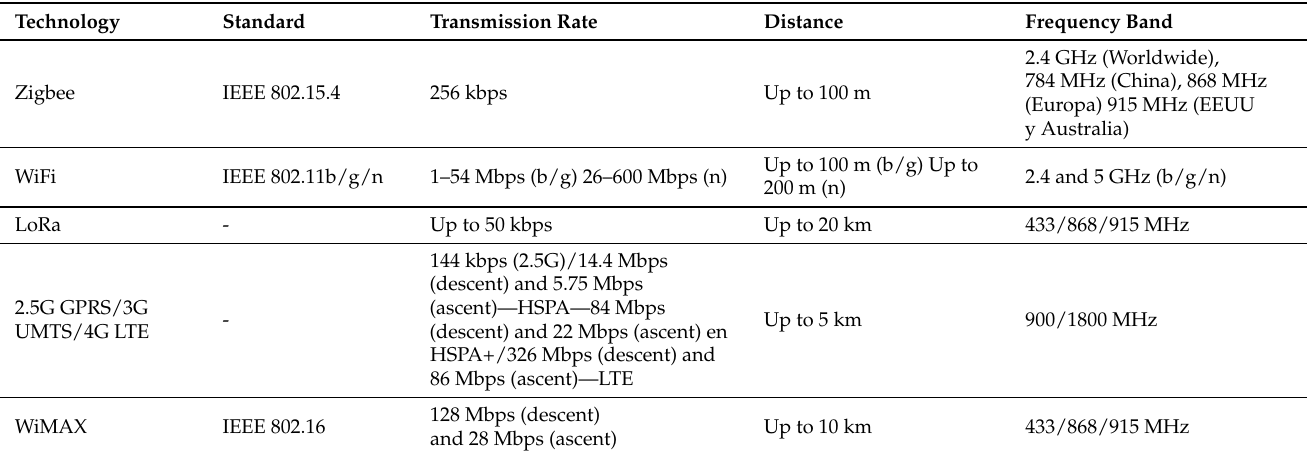
Table 2. Wireless technology